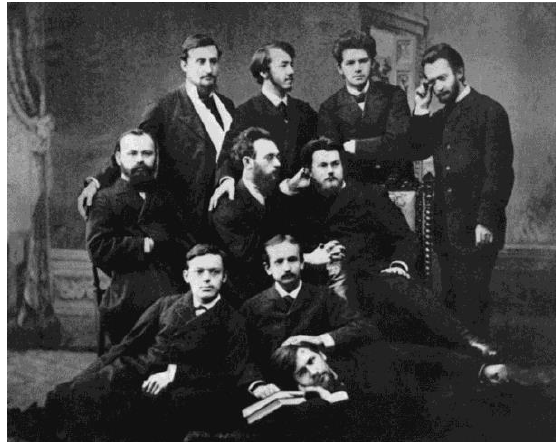
Figure 5. From left to right are: Dmitry